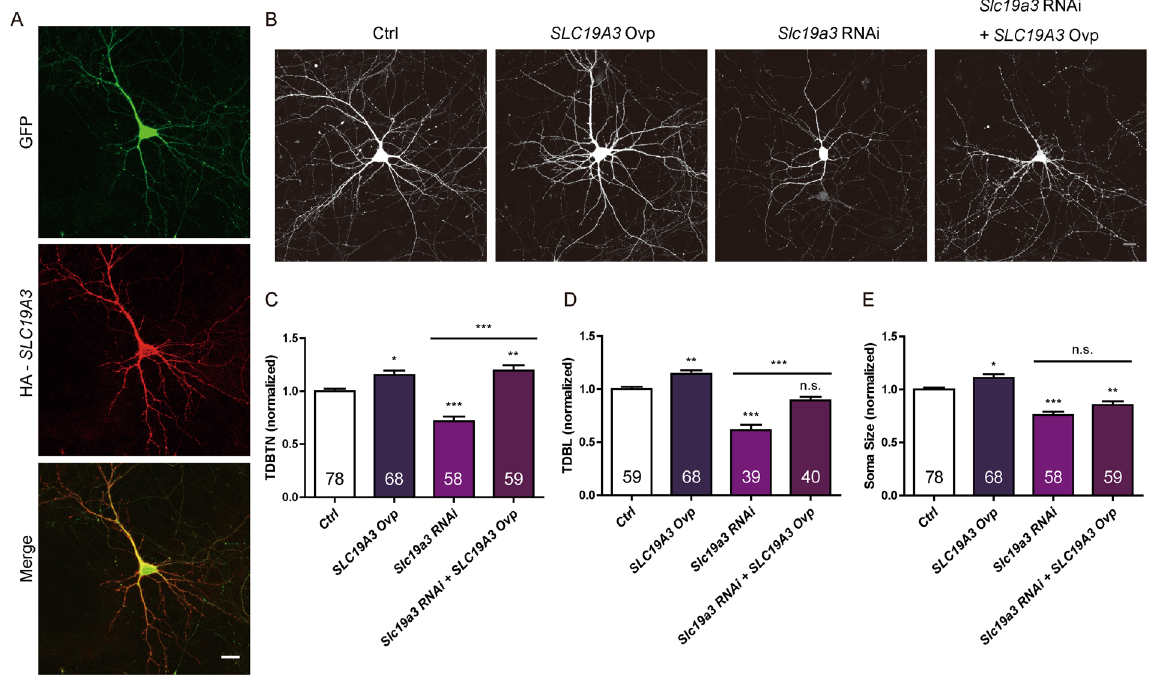
Figure 6. Overexpression of human SLC19A3 significantly rescued the reduction of TDBTN and TDBL induced by Slc19a3 RNAi. ( A ) Immuostaining of DIV11 neuron transfected with GFP and HA- SLC19A3 constructs. ( B ) Representative images of DIV10 neurons, conditions as indicated. ( C ) Quantitation of TDBTN: Ctrl (1.00 ± 0.02), SLC19A3 Ovp (1.16 ± 0.04, P < 0.05 vs Ctrl), Slc19a3 RNAi (0.72 ± 0.04, P < 0.001 vs Ctrl), Slc19a3 RNAi + SLC19A3 Ovp (1.20 ± 0.05, P < 0.01 vs Ctrl, P < 0.001 vs Slc19a3 RNAi). ( D ) Quantitation of TDBL: Ctrl (1.00 ± 0.02), SLC19A3 Ovp (1.15 ± 0.03, P < 0.01 vs Ctrl), Slc19a3 RNAi (0.61 ± 0.05, P < 0.001 vs Ctrl), Slc19a3 RNAi + SLC19A3 Ovp (0.90 ± 0.03, n.s. vs Ctrl, P < 0.001 vs Slc19a3 RNAi). ( E ) Quantitation of soma size: Ctrl (1.00 ± 0.02), SLC19A3 Ovp (1.11 ± 0.03, P < 0.05 vs Ctrl), Slc19a3 RNAi (0.76 ± 0.03, P < 0.001 vs Ctrl), Slc19a3 RNAi + SLC19A3 Ovp (0.86 ± 0.03, P < 0.01 vs Ctrl, n.s. vs Slc19a3 RNAi). One-way ANOVA followed by Tukey’s post-test. Scale bar: 20 μ